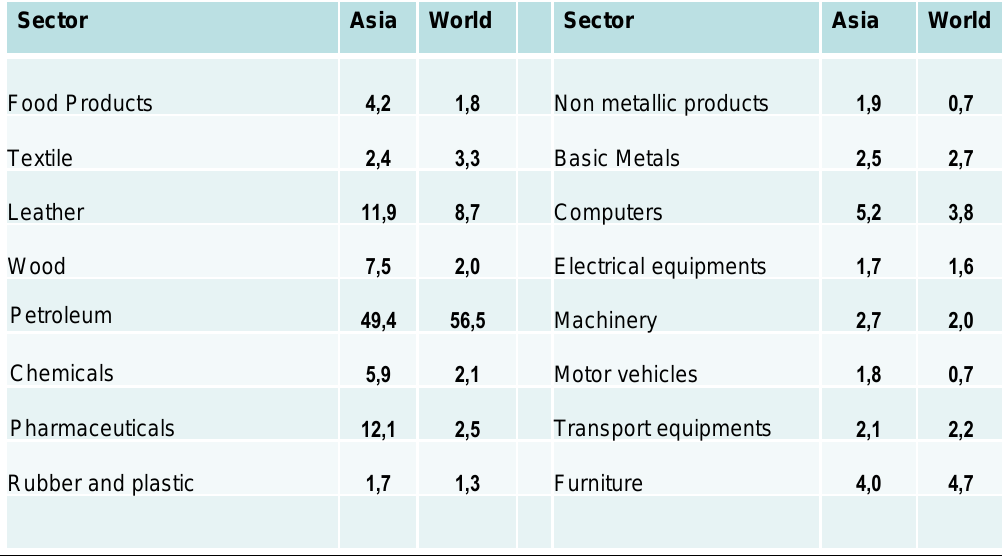
Table 5: Italian Export over Italian Affiliates Abroad